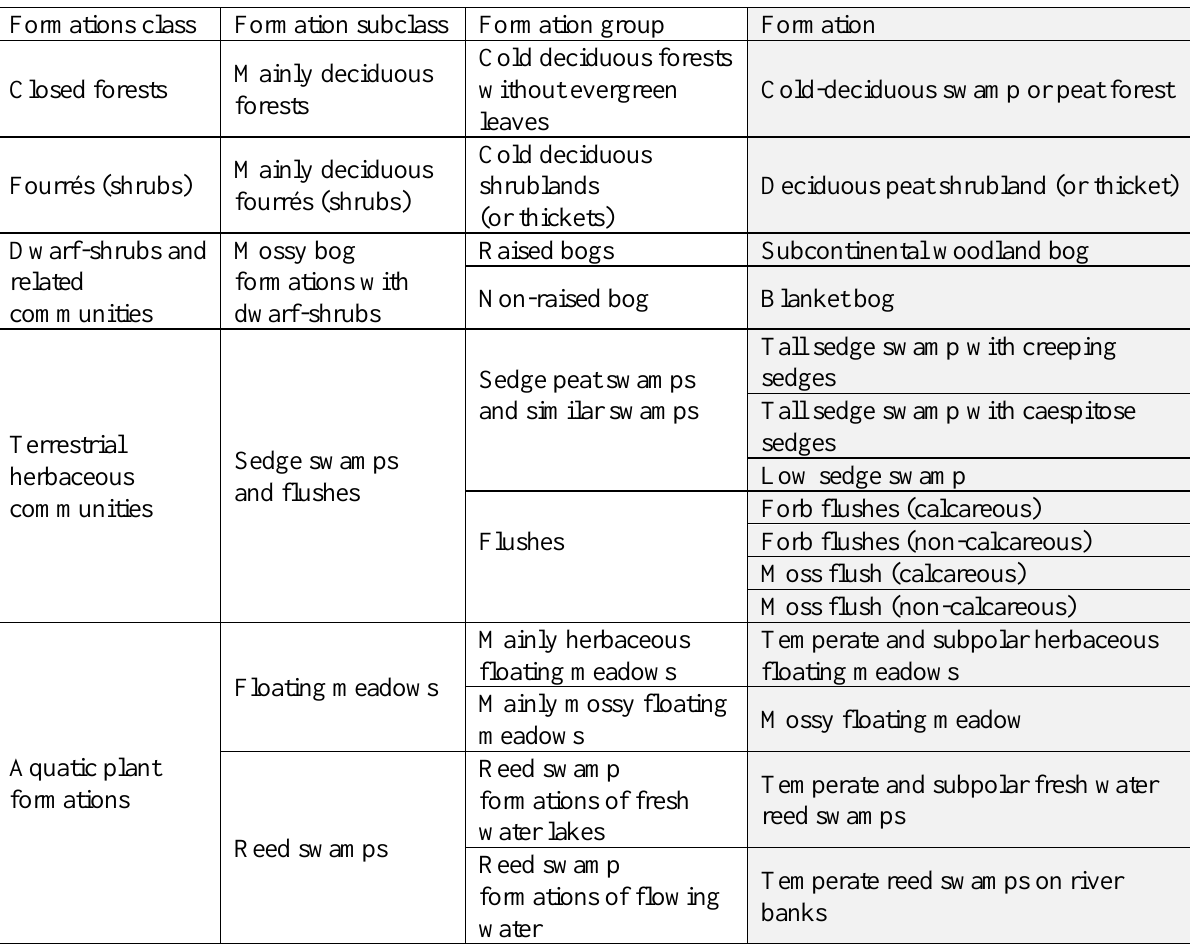
Table 3. Mire-specific and mire-typical plant formations occurring in the federal state of Brandenburg (north- east Germany). Remark: Species inventory and micro-relief as described in Ellenberg & Müller-Dombois